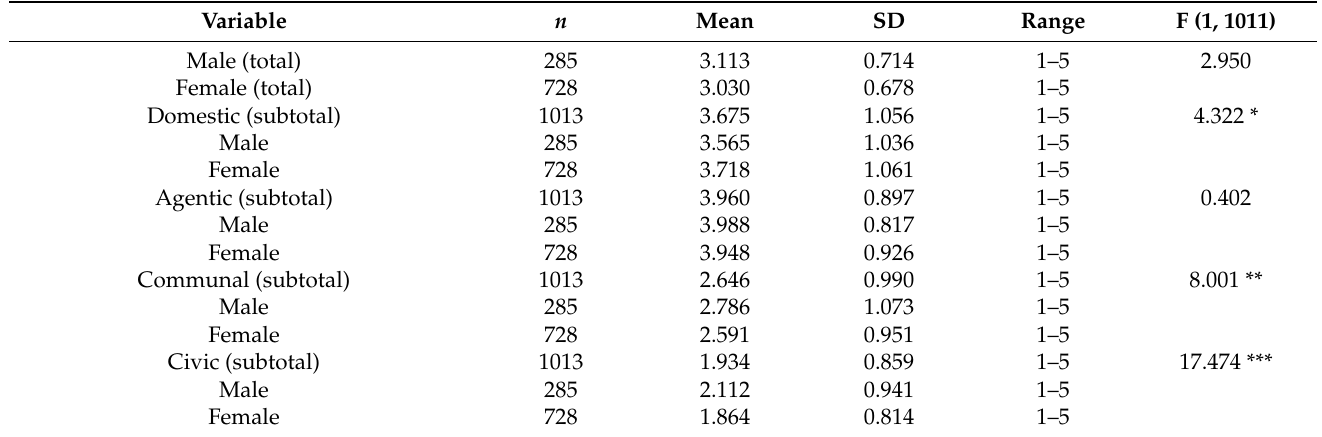
Table 5. Mean comparisons of the total and subscales of the GSA-C by gender.